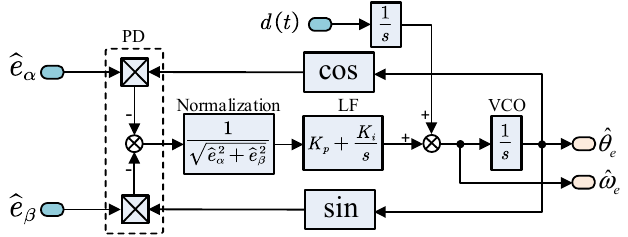
Figure 3. Block diagram of the conventional QPLL considering the acceleration disturbance.